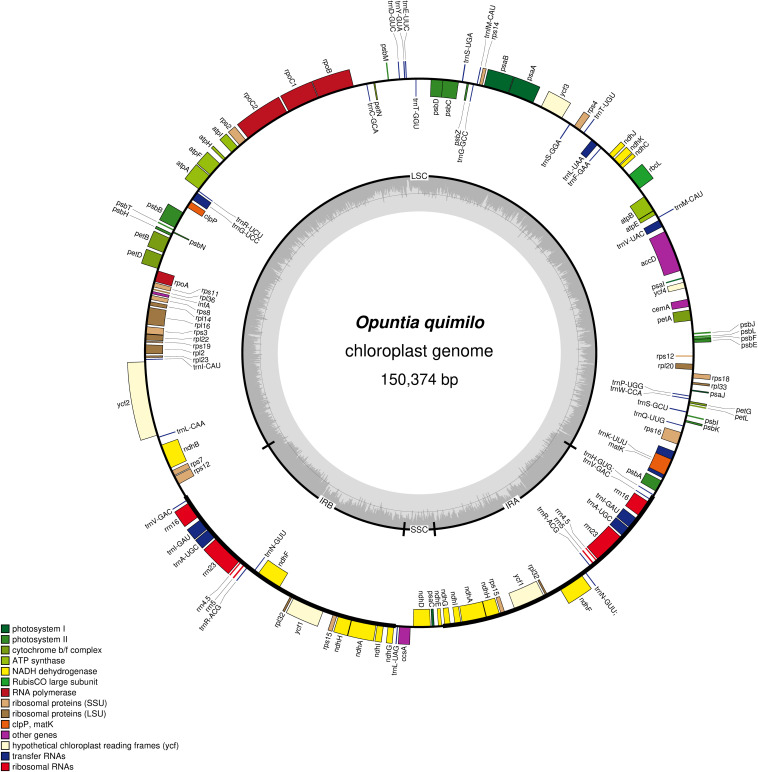
Circular map of chloroplast genome of Opuntia quimilo with annotated genes. The genes transcribed clockwise are shown inside of the circle, whereas genes transcribed counter clockwise are shown outside of the circle. The borders of chloroplast genome are defined with LSC, SSC, IRa, and IRb. The dashed gray color of inner circle shows the GC content.